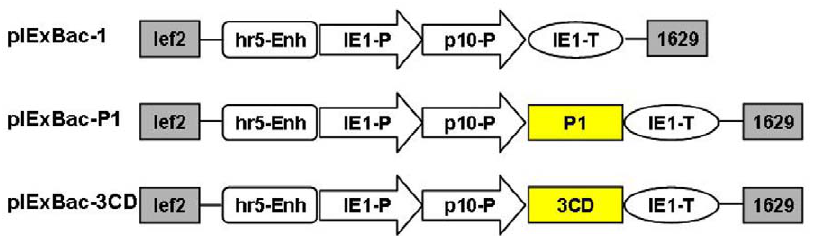
Figure 1. Diagrams of the constructs used in this study. lef2, the left sequence for homologous recombination; hr5-Enh, AcNPV hr5 enhancer; IE1-P, IE1 immediate early promoter; p10-P, p10 promoter; IE1-T, IE1 terminator; 1629, the right sequence for homologous